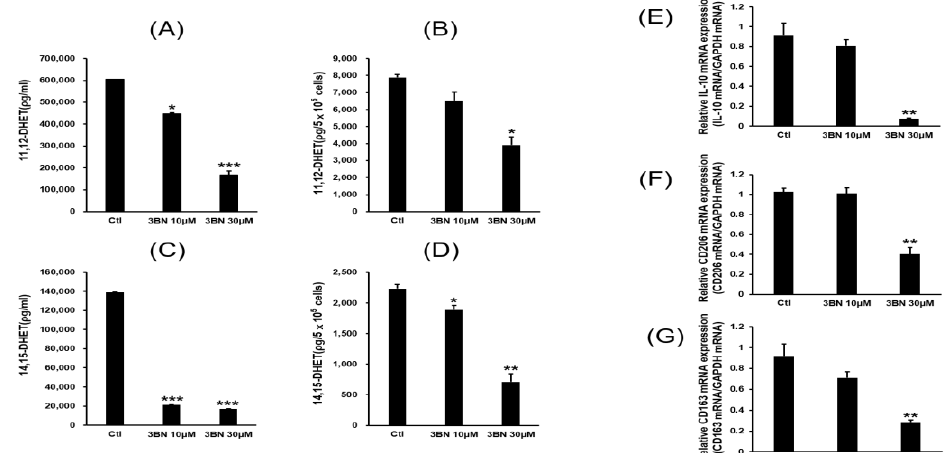
Figure 7. Reduced mRNA expression of selected M2 macrophage marker genes together with a decreased amount of CYP2C19 metabolites by the CYP2C19 inhibitor treatment. The effect of CYP2C19 inhibitor (3BN) on the CYP2C19 metabolites of ( A ) 11,12-DHET in culture media, ( B ) 11,12-DHET in cells, ( C ) 14,15-DHET in culture media, and ( D ) 14,15-DHET in cells. The expression levels of M2 macrophage marker genes were assessed using quantitative real time PCR. ( E ) IL-10 mRNA, ( F ) CD206 mRNA, and ( G ) CD163 mRNA. M2 macrophages were treated with 0, 10, and 30 µ M 3BN for 24 h. Metabolite analysis and qRT-PCR were performed as described in the Materials and Methods. Data are expressed as the mean ± standard deviation of triplicate experiments. * p < 0.05, ** p < 0.01, and *** p < 0.001 versus the control.